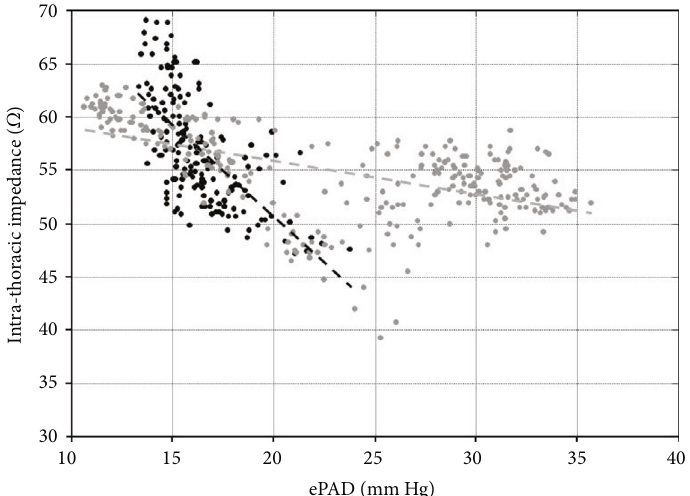
Figure 3: Daily averaged ePAD (mmHg) vs. intrathoracic impedance ( Z ; Ω ). Two subpopulations of points relating ePAD to Z coupled to episodes before (grey) and during dialysis (black) can be identi fi ed. A signi fi cant relation ( r = − 0 : 56 ) but with only a moderate negative slope (-0.31) was found between ePAD and Z before dialysis ( n = 282 days). During dialysis, a stronger negative relation was observed ( r = − 0 : 68 ; slope = − 1 : 71 , n = 179 days).